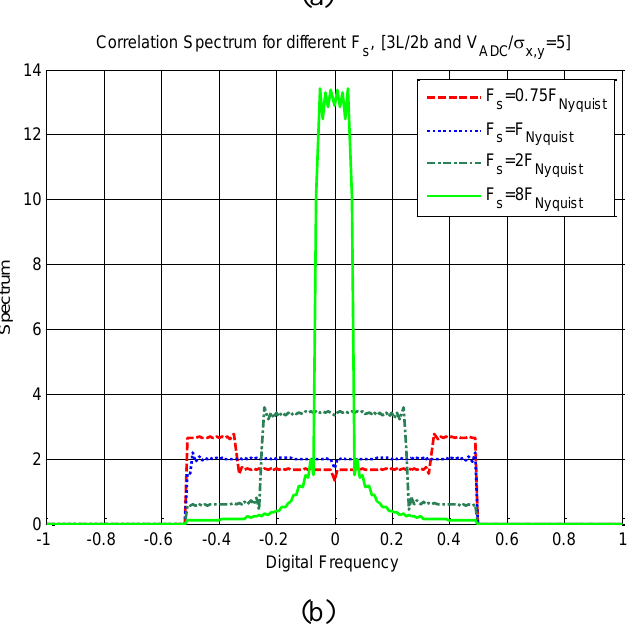
Figure 9. Impact on the quantized correlation of different sampling frequencies. For 2 quantization levels, a bandwidth 2B (assuming a band-pass signal), and V (a) shows the fringe-washing function deformation, and (b) shows the effect on their